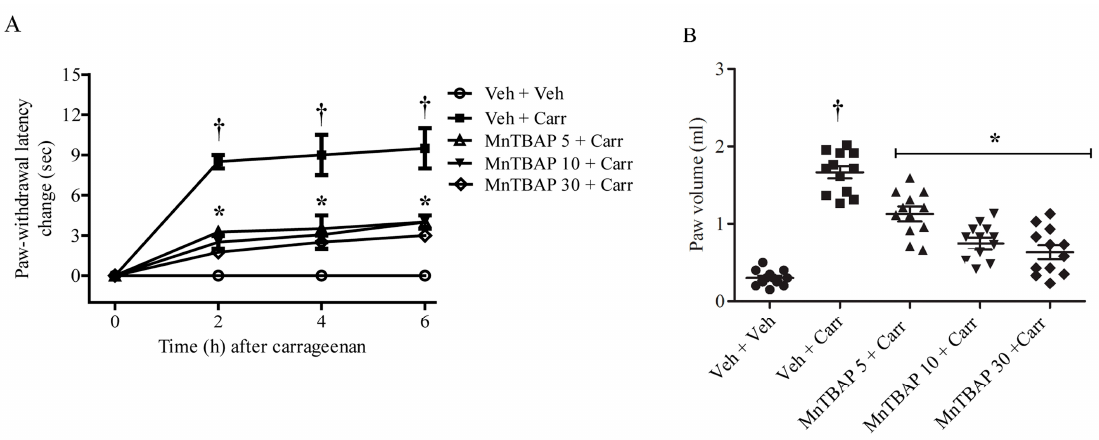
Figure 1. ( A ) Intraplantar injection of carrageenan caused thermal hyperalgesia. This response was blocked by Mn (III) tetrakis (4-benzoic acid) porphyrin (MnTBAP) (5–30 mg/kg). Drugs were given intraperitoneally (i.p.) 15 min before the intraplantar injection of carrageenan. ( B ) The development of thermal hyperalgesia coincided with oedema formation. Injection of different doses of MnTBAP (5–30 mg/kg) was able to reduce oedema. The paw volume (mL) obtained at 6 h after the intraplantar injection of carrageenan. Results are expressed as mean ± SEM for 12 rats. Results are expressed as mean ± SEM for 12 rats. † p < 0.05 compared to Veh + Veh; * p < 0.05 compared to Veh + Carr.